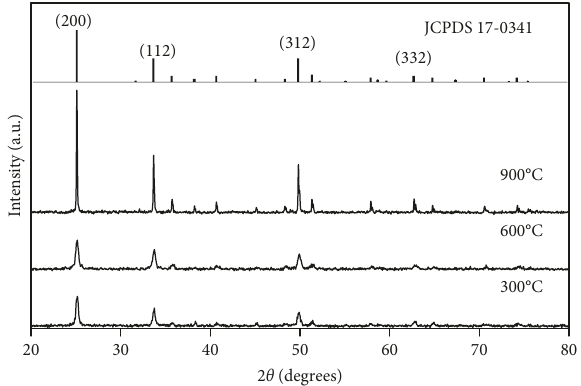
Figure 6: XRD samples of YVO different annealing